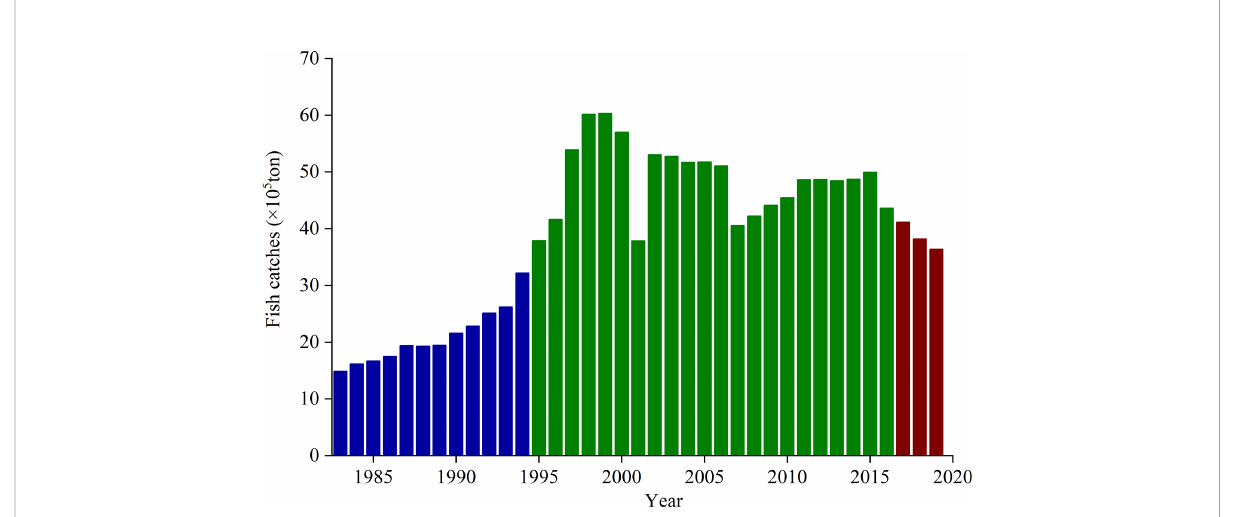
FIGURE 6 Changes in annual fi sh catches in Bohai, Yellow, and northern East China seas. The data are from Chinese fi shery statistics, which were collected from Liaoning, Hebei, Tianjin, Shandong, Jiangsu, Shanghai, and Zhejiang. The blue column re fl ects the annual fi sh catches before the summer fi shing moratorium was established. The green column represents the annual fi sh catches from 1995 to 2016, when the summer fi shing moratorium started after early June. The red column represents the annual fi sh catches after 2017, when the fi shing ban was enforced more rigorously and forcefully on May